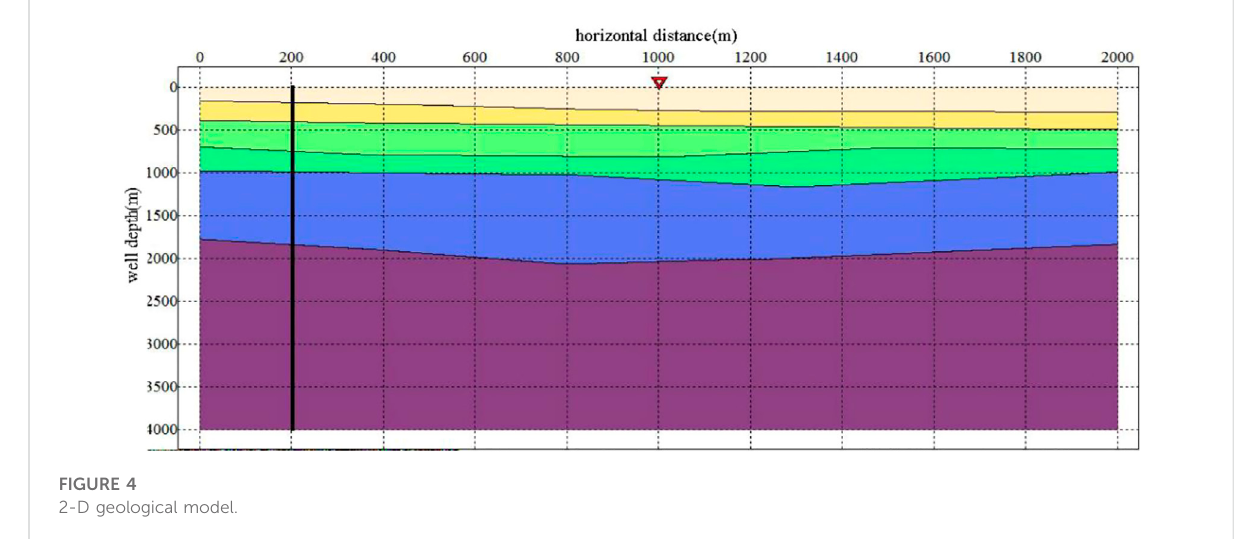
FIGURE 4 2-D geological model.